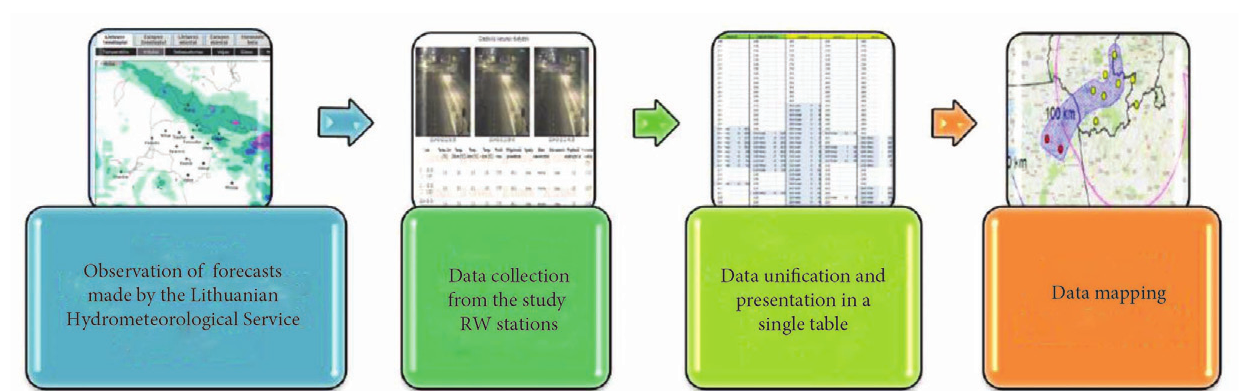
Fig. 4. The steps of